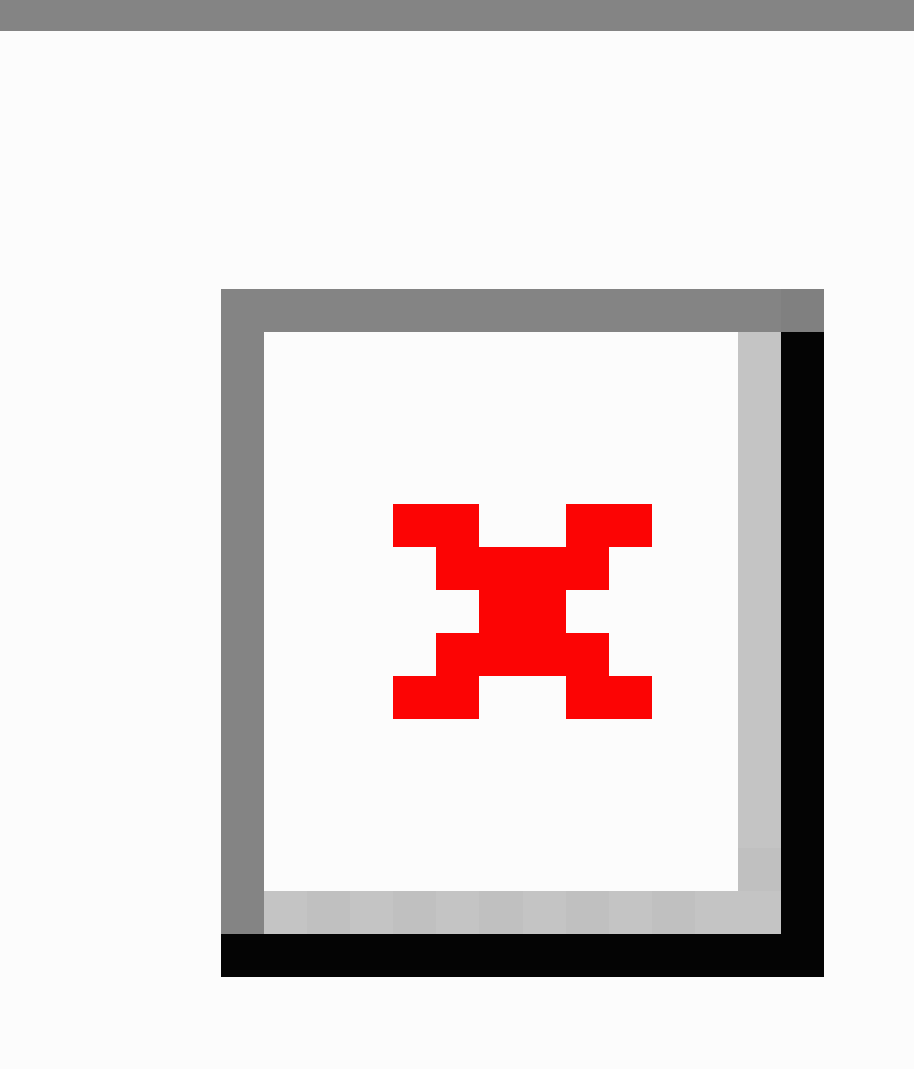
Figure 2. Health care cloud computing strategic planning (HC 2 SP) model (SWOT = strengths, weaknesses, opportunities, and threats; VOC = voice of